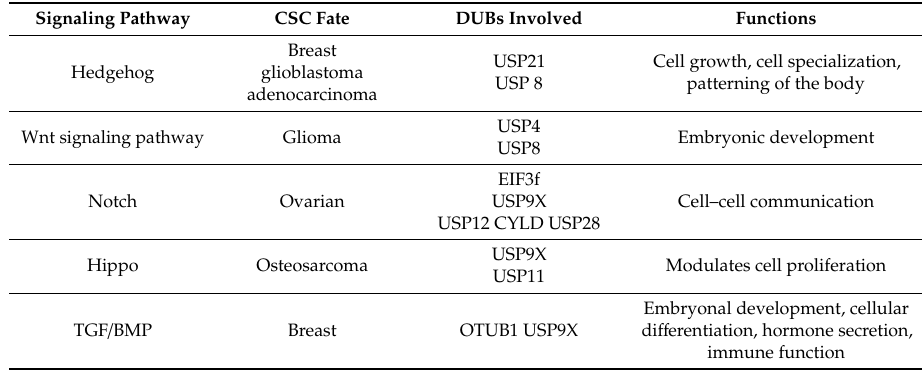
Figure 4. Regulation of Cancer stem cell-associated signaling pathways by key DUBs. Six main pathways that play significant roles in sustaining the stemness of Cancer stem cells are represented: ( a ) Sonic hedgehog signaling, ( b ) Wnt signaling, ( c ) Notch signaling, ( d ) Transforming growth factor signaling, and ( e ) Hippo signaling. Positive regulatory DUBs are depicted in green font and negative regulatory DUBs are depicted in red font. Table 2. DUBs associated with stemness signaling pathways.